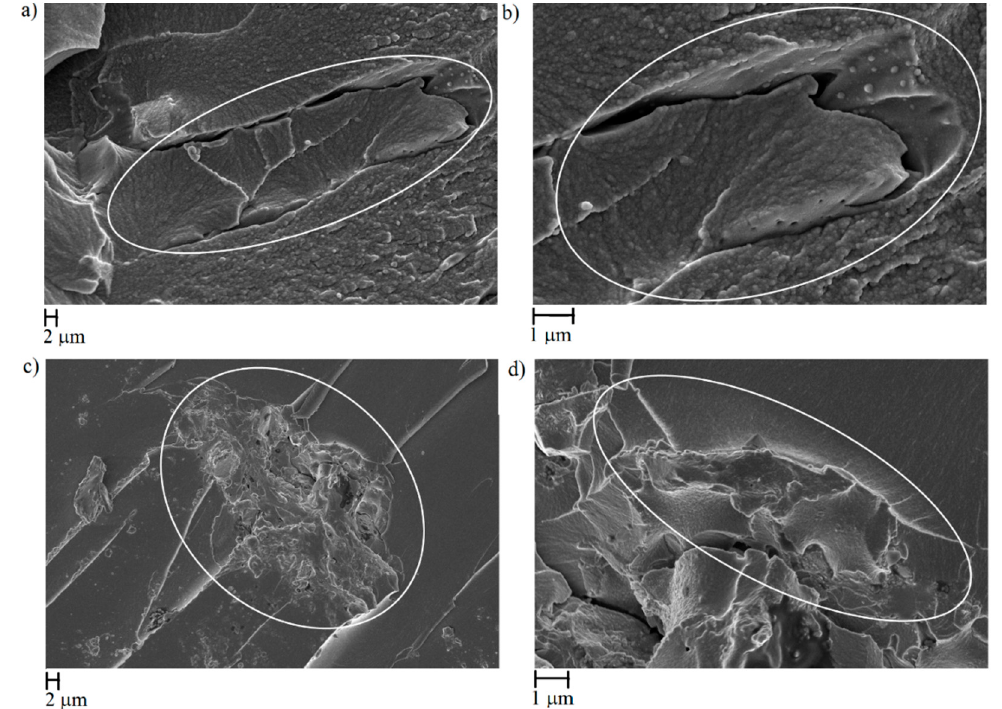
Figure 8. FE-SEM captures of composites containing ( a , b ) MSP and ( c , d ) WSP after the fracture. FE-SEM. Interphases between biochar particles and resin are highlighted with white circles.